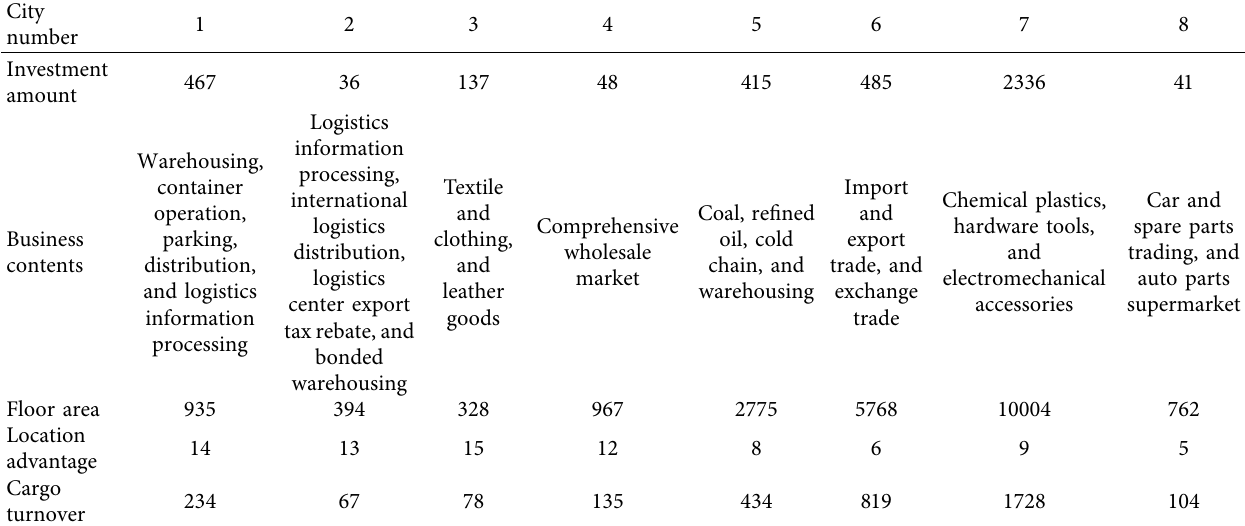
Table 7: Scores of different types of logistics parks in the eight cities.